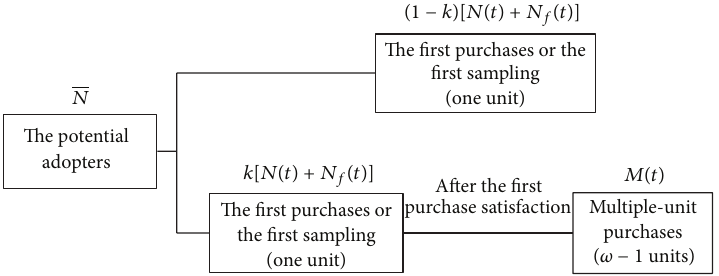
Figure 1: Diffusion pattern of new product incorporating individual and multiple-unit